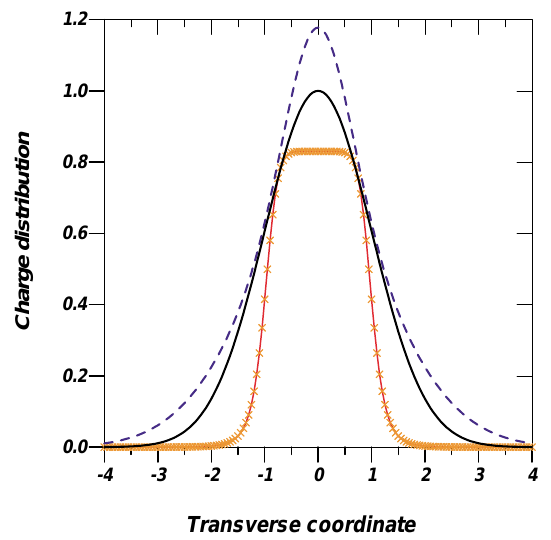
FIG. 7. (Color) Charge distributions. The solid line is Gaussian for antiprotons; 3 -marked line is the electron beam with r e (cid:2) r (cid:3) ~ 0.83 ; dashed line is optimized electron beam 1 1 (cid:2) r (cid:4) s (cid:3) 8 distribution; see Eq. (8) and